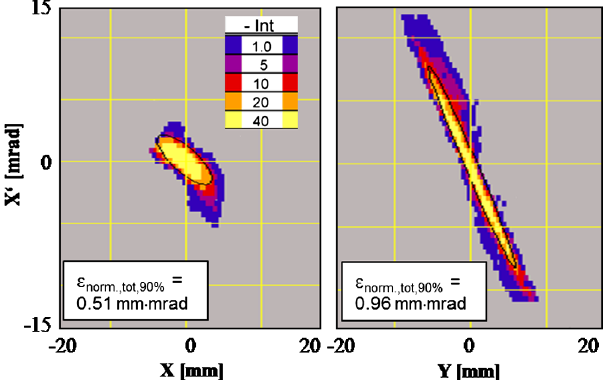
FIG. 3. Measured horizontal and vertical high current (11.5 emA) U 29 þ -beam emittance (at 1 . 4 MeV = u).